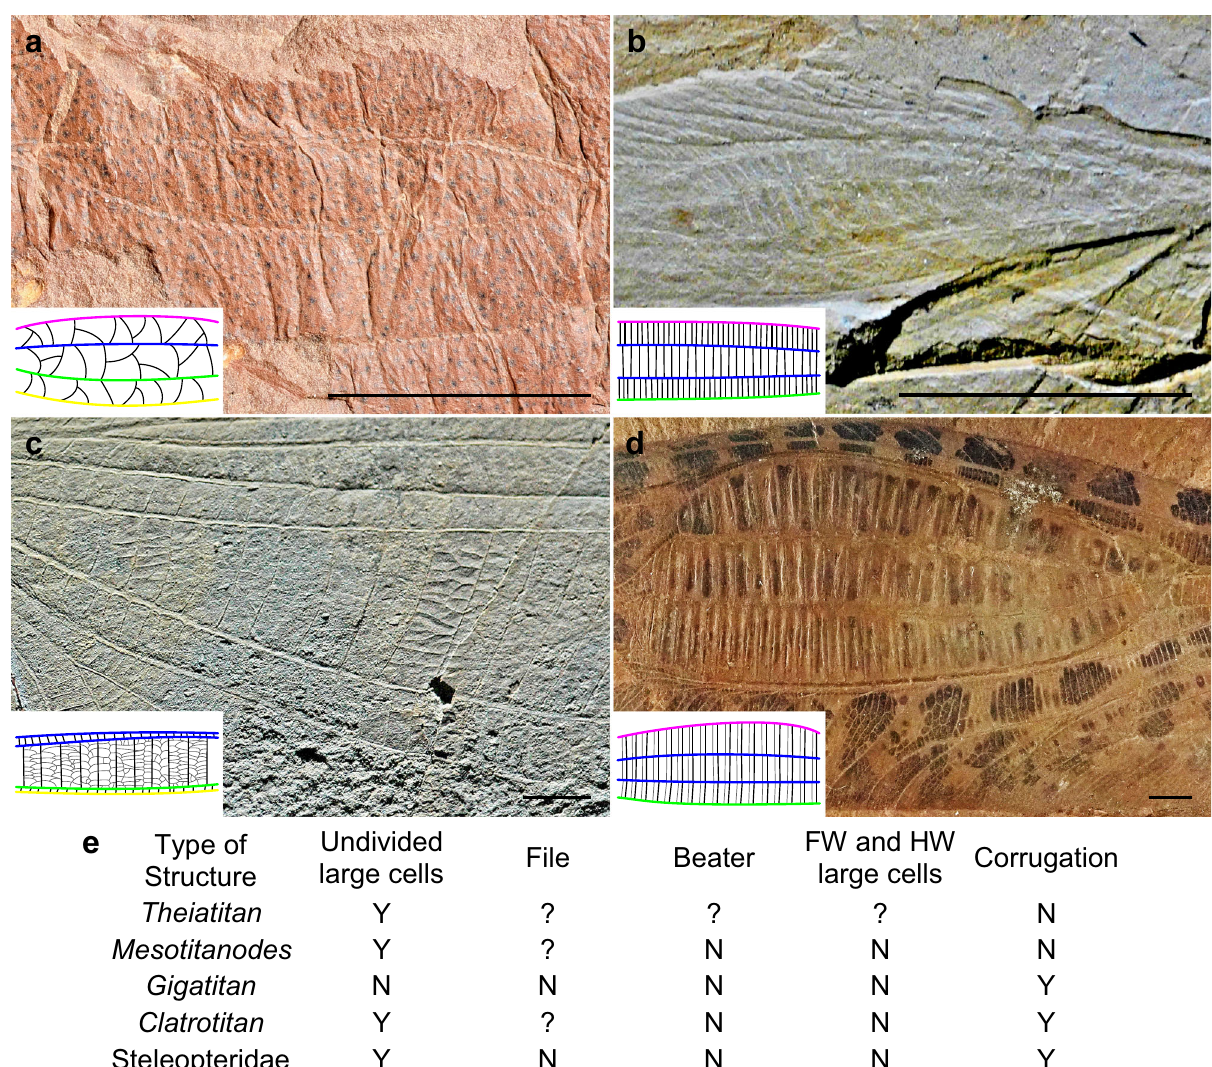
Fig. 5 Diversity of broadened specialized areas in Titanoptera. a Theiatitan , areas between RP, M, CuA and CuP, series of relatively irregular intercalary veinlets separating large cells. b Mesotitanodes , area between branches of M with regular large cells. c Gigatitan , area between branches of M with regular large cells subdivided into irregular nets of small cells. d Clatrotitan , areas between RP, branches of M, and CuA, with highly specialized cells. Scale bars: 5 mm. e Distribution of the structures used to communicate (see Fig. 2 for more details) among the Titanoptera. Colors of veins: pink radial vein; blue median vein; green cubitus anterior vein; yellow cubitus